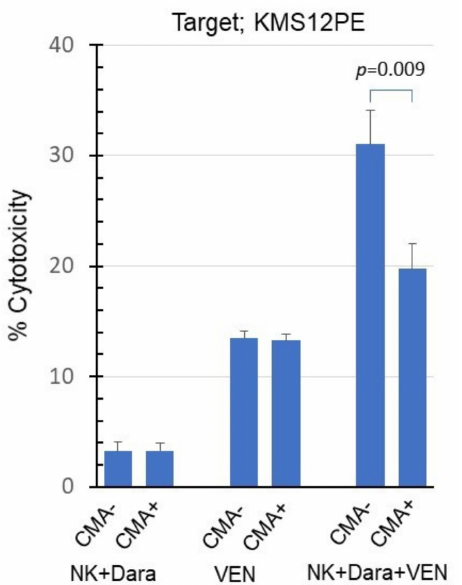
Figure 5. Synergistic cytotoxicity of NK cell mediated ADCC with daratumumab and venetoclax to MM cell lines. Cytotoxicity of NK cell mediated ADCC with daratumumab and venetoclax to MM cell lines, KMS12PE, KMS27, U266 and KM5 was measured by flow cytometry with annexin V. MM cell lines were cocultured with NK cells at effector/target (E/T) ratios: 0.3 with serial concentrations of daratumumab and venetoclax. Cytotoxicity is shown as the mean of three different assays. Red, black, and gray lines indicate the cytotoxicity of NK cells with daratumumab and venetoclax (NK + Dara + VEN), NK cells with daratumumab (NK + Dara), and venetoclax (VEN), respectively. *—differences between groups 0.01< p < 0.05, the Student’s t-test. **—differences between groups p < 0.01, the Student’s t-test. The perforin inhibitor concanamycin A (CMA) did not inhibit the cytotoxicity of venetoclax alone but clearly inhibited the synergistic cytotoxicity of daratumumab and venetoclax (Figure 6).